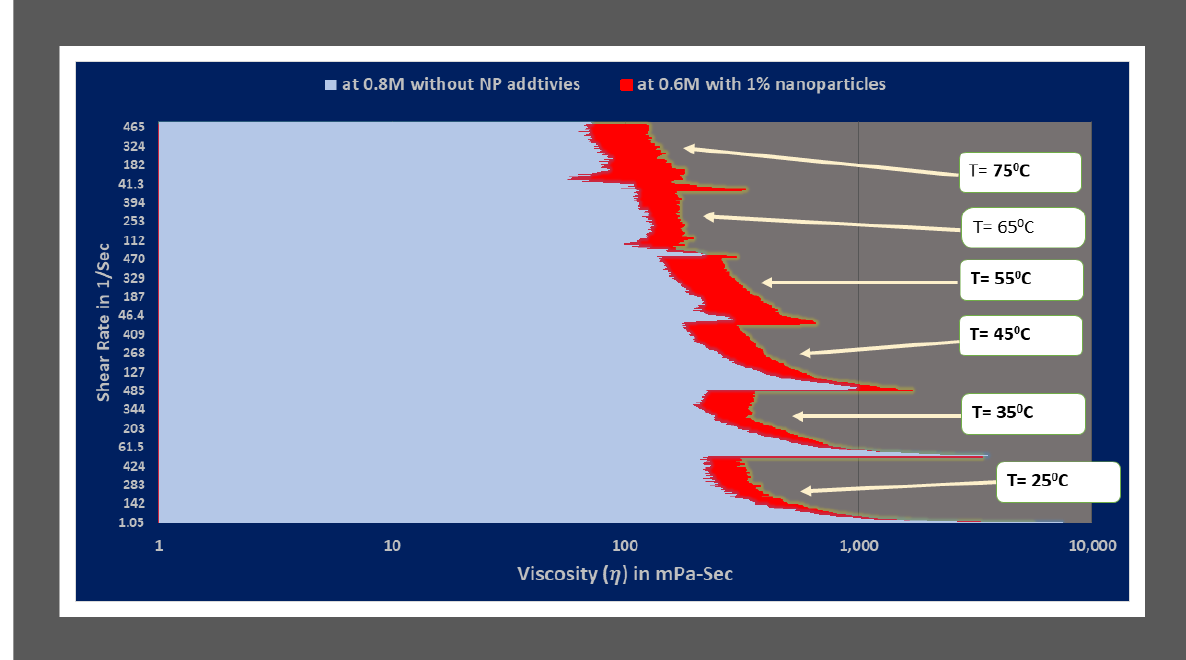
Figure 10. Rheology comparison in terms of viscosity of optimum viscoelastic fluids of type1 (without NP additives) and type2 (with NP additives) categories. NP additives) and type2 (with NP additives)